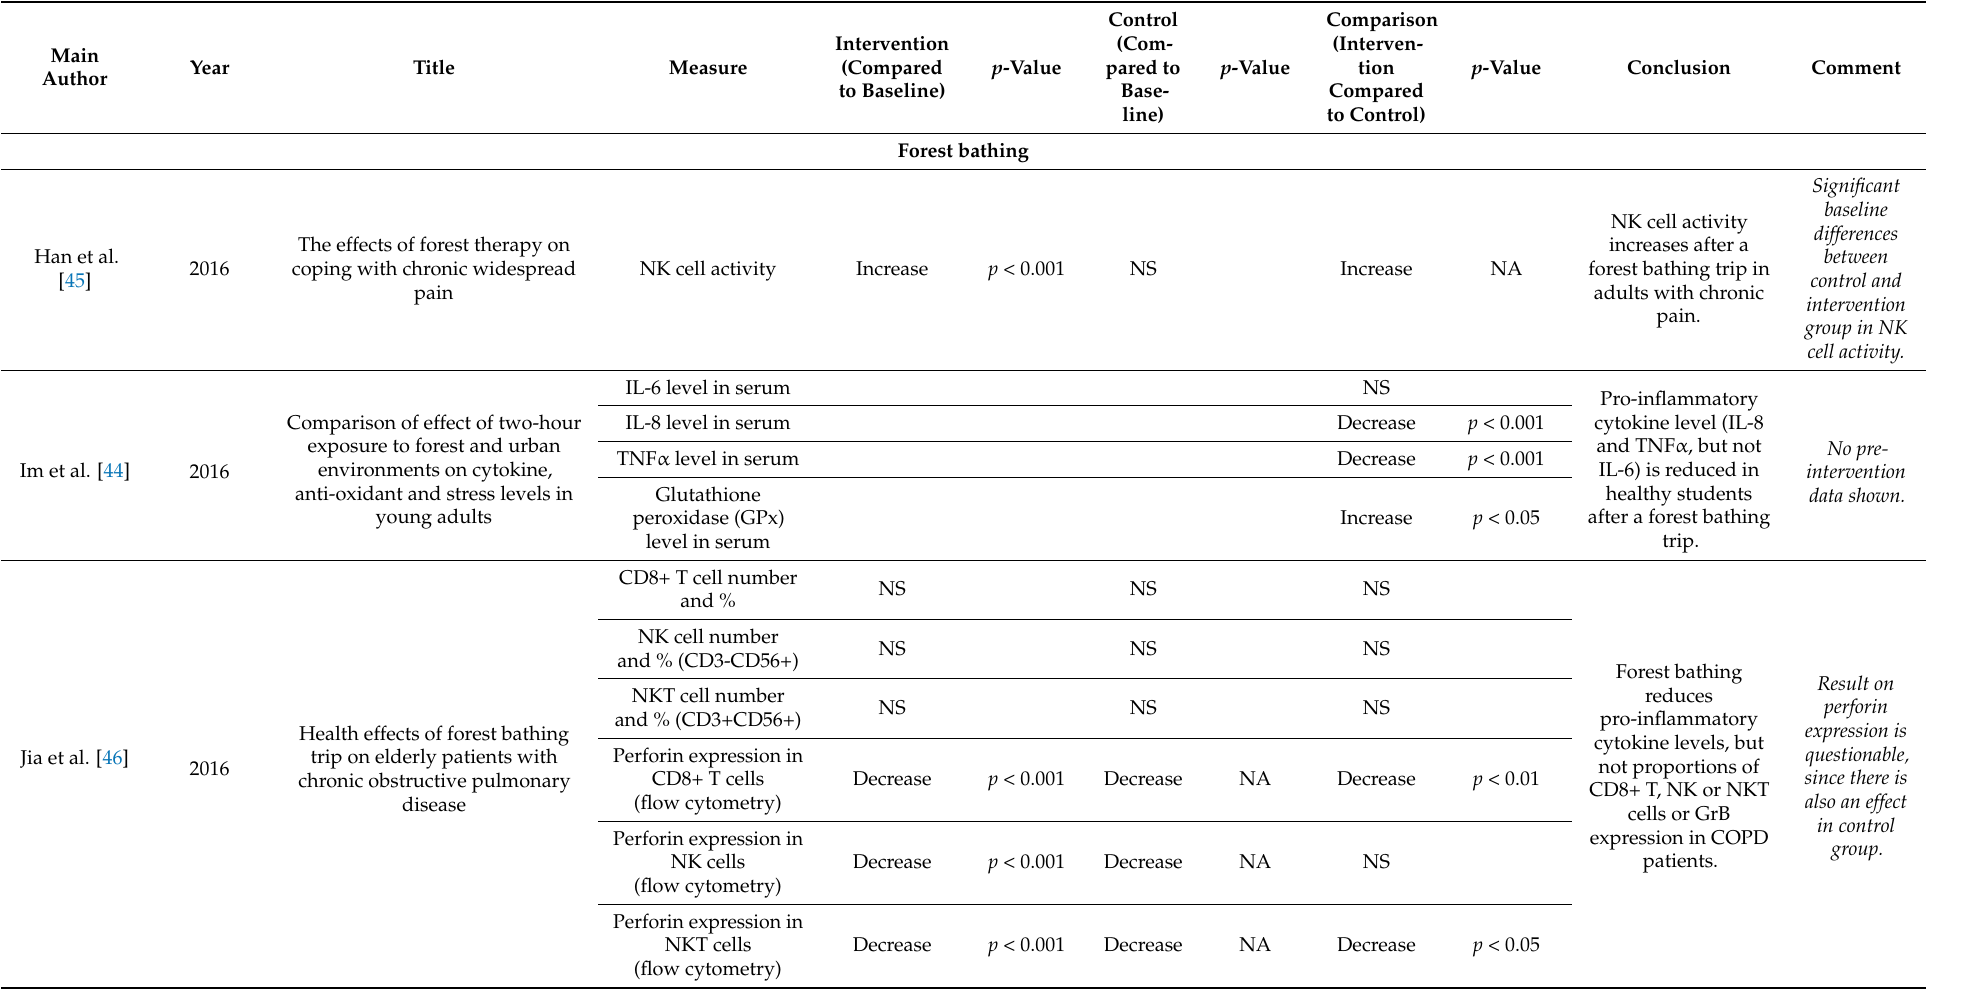
Table 5. Outcomes of human studies. Significances are given with p < 0.05, p < 0.01 and p < 0.001; NS = not significant, NA = not applicable. A non-significant trend is described as “Decrease/Increase, NS”. If significances are not given, it is described as “Decrease/Increase,